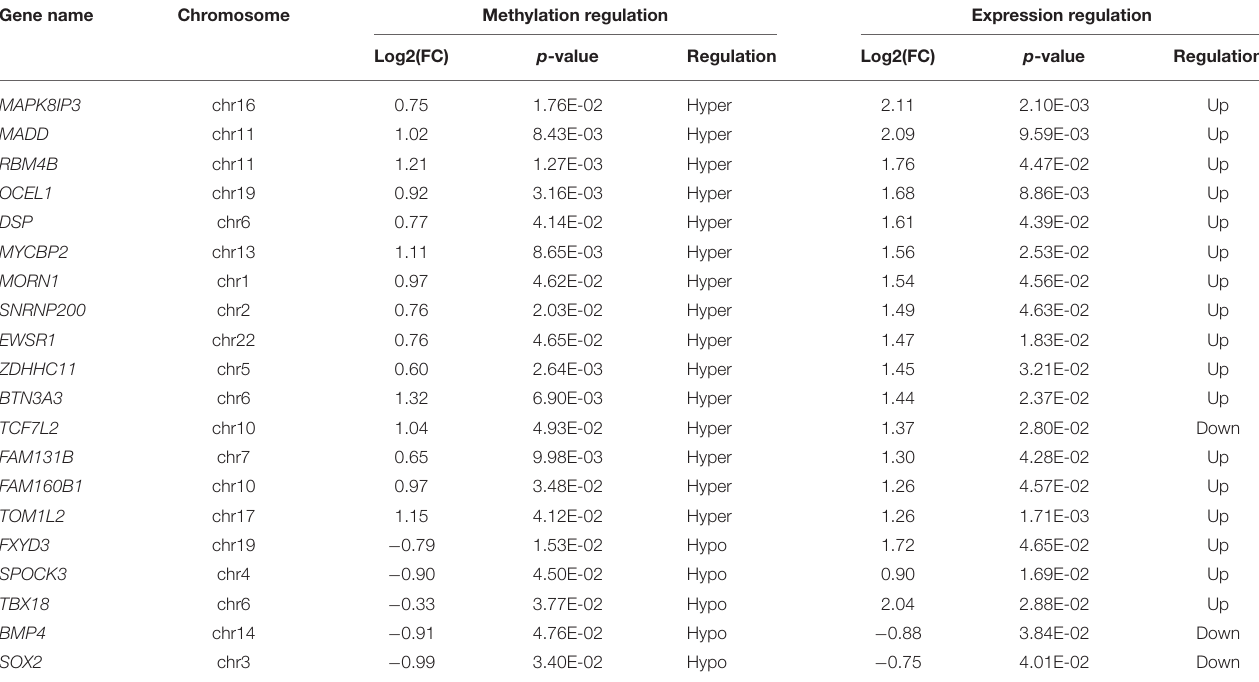
TABLE 2 | The top 20 differently methylated mRNAs with differential expressions.